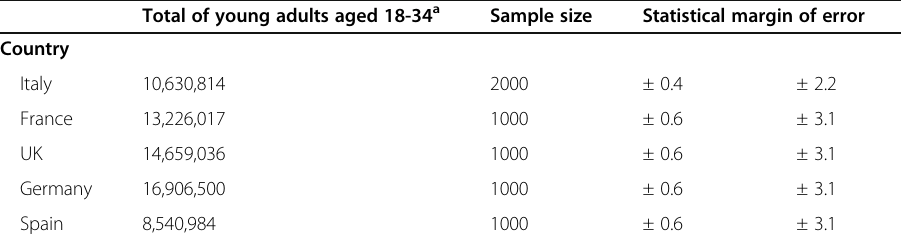
Table 7 Sample details as collected in the Youth project official statement (Istituto Toniolo,